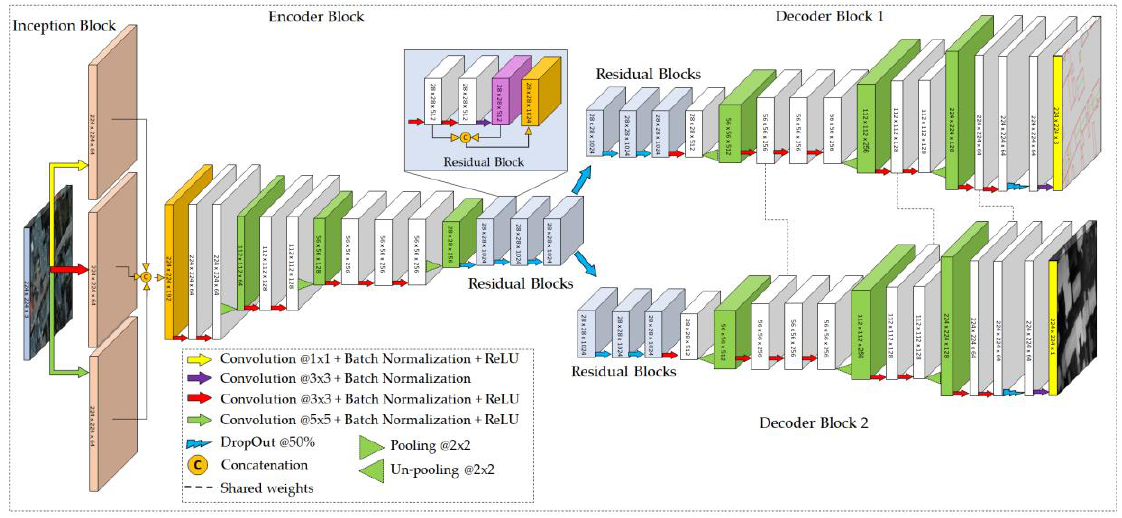
Figure 3. The proposed